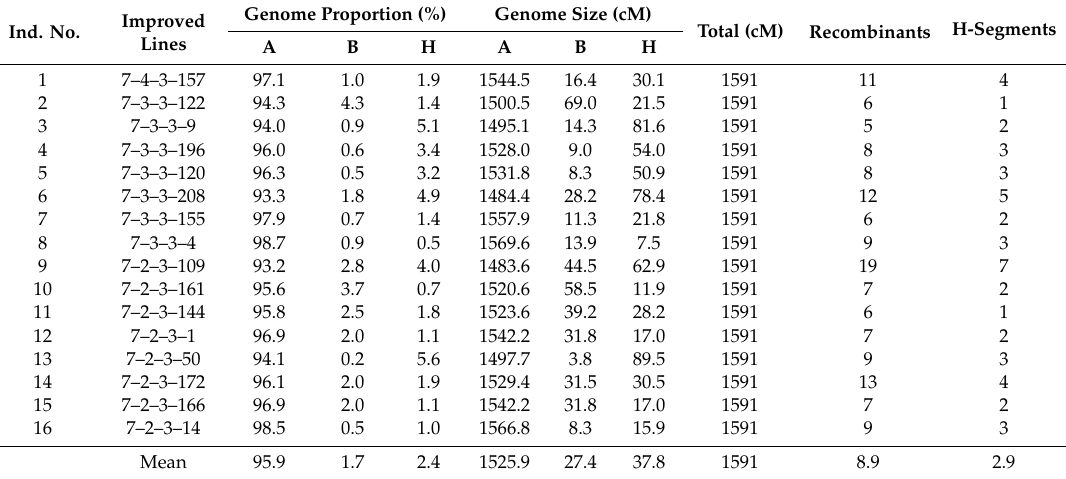
Table 2. Percentage RPGR and heterozygous segment of selected BC 2 F 2 lines. Ind. No.